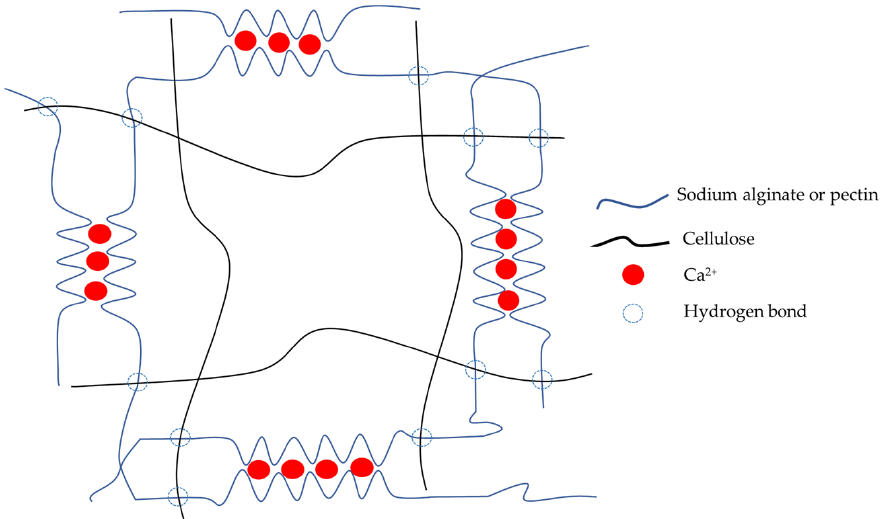
Figure 5. The illustrative scheme of hydrogel